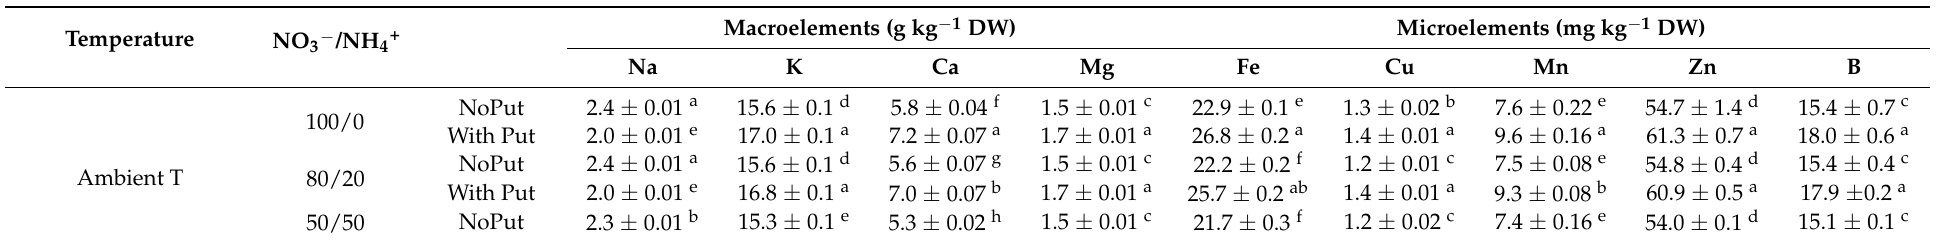
Table 6. Effect of foliar application of putrescine (2.5 mM) on cations in outer leaves of the cauliflower cv. Moonshine at different ration of NO 3 − /NH 4+ and temperatures.